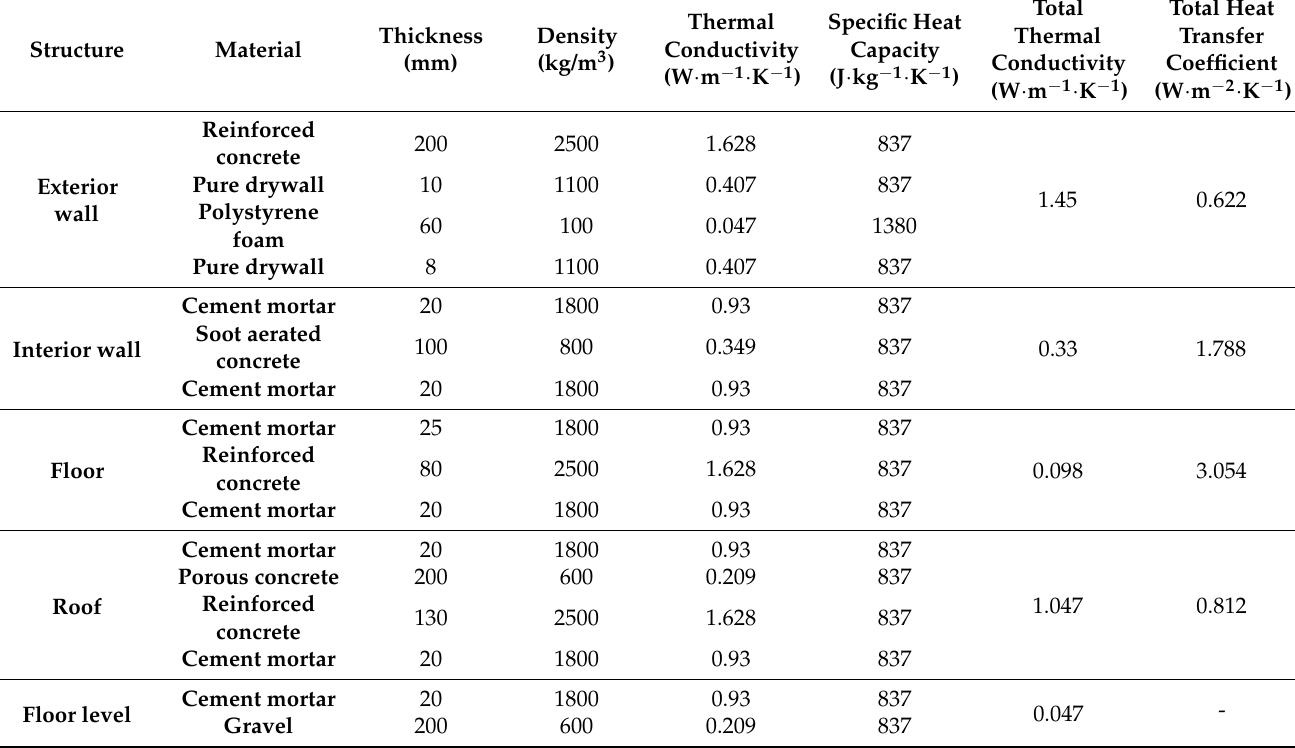
Table 17. Parameters of building envelope in